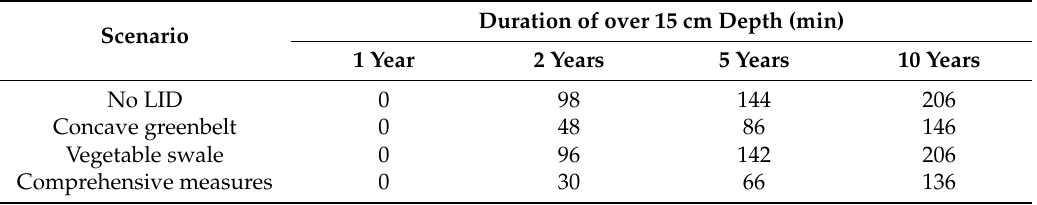
Table 10. Durations of ponding depth over 15 cm in different